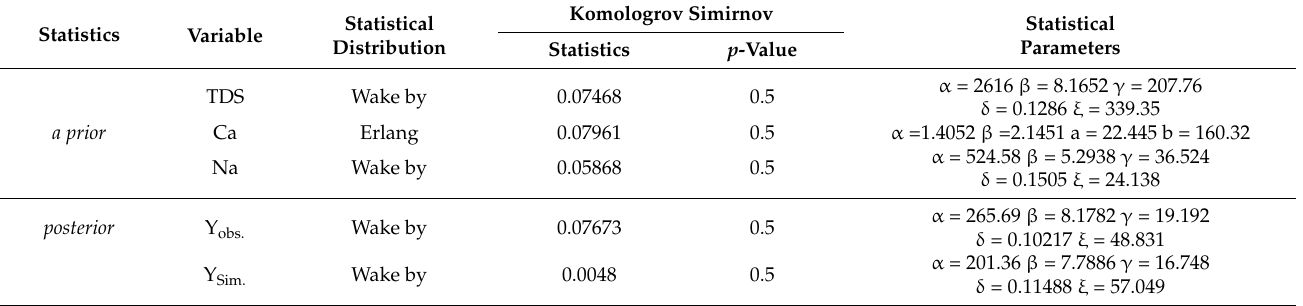
Table 8. Results of the statistical distribution for the ANN CGD training algorithm-based MLR model.